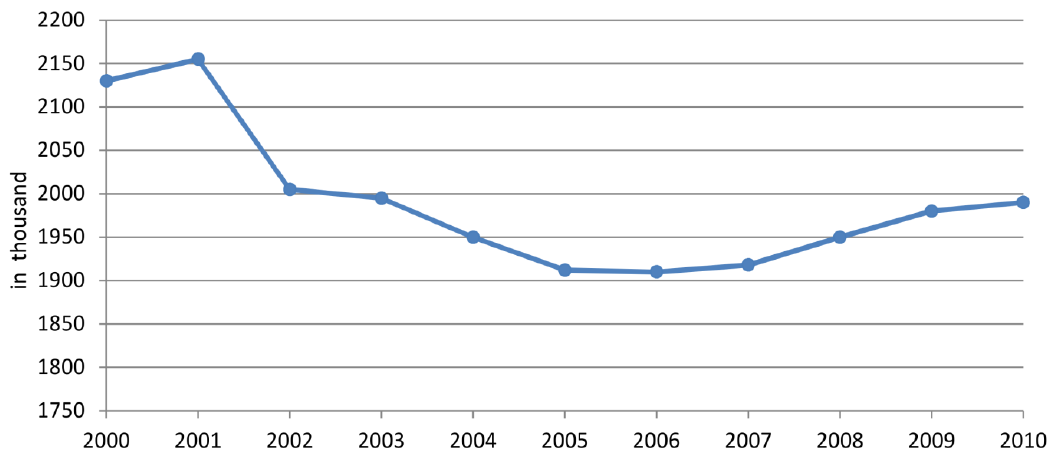
Fig. 2. Changes in the number of people working for businesses registered with the REGON system in the Silesian voivodeship in the period from 2000 to 2010 (after Sitek et al., 2013)